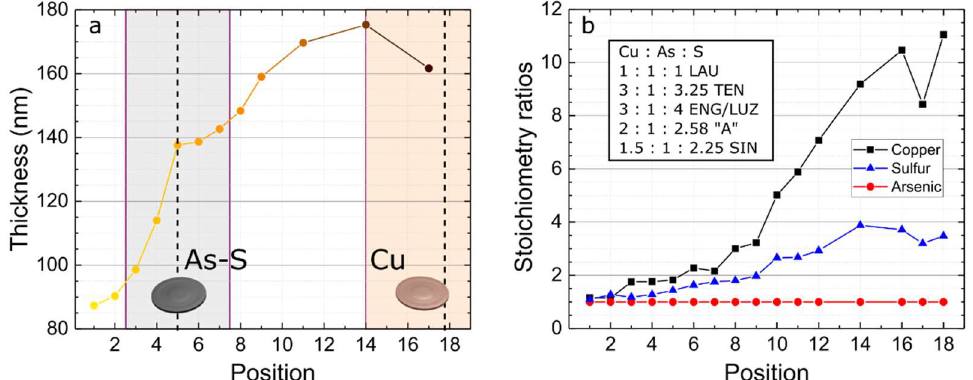
Figure 2. ( a ) Film thickness obtained by profilometry. The colored areas of the plot illustrate the positions of the substrate that are directly above each target (As-S in grey, Cu in orange) and the dashed vertical lines denote the center of the target ( b ) Stoichiometry ratios of Cu/As, S/As and As/As obtained by EDS with inset table presenting the various known phases of CAS.